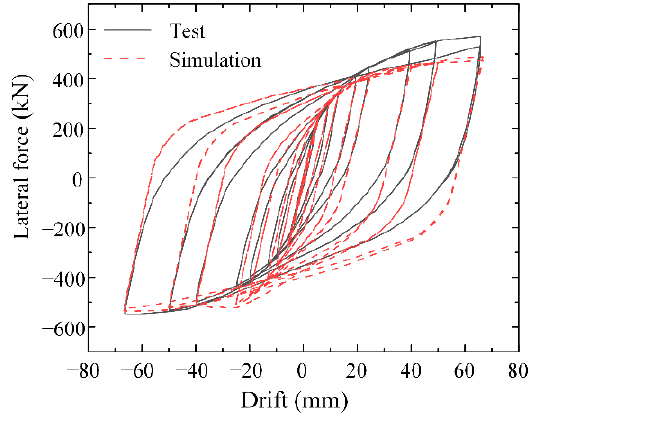
Figure 7. Comparison of simulation and test hysteresis curve: ( a ) BLY225 − 1, ( b ) V1, ( c ) V2, ( d ) BRBCF3; ( e ) BRBF3; ( f ) BRBF5.